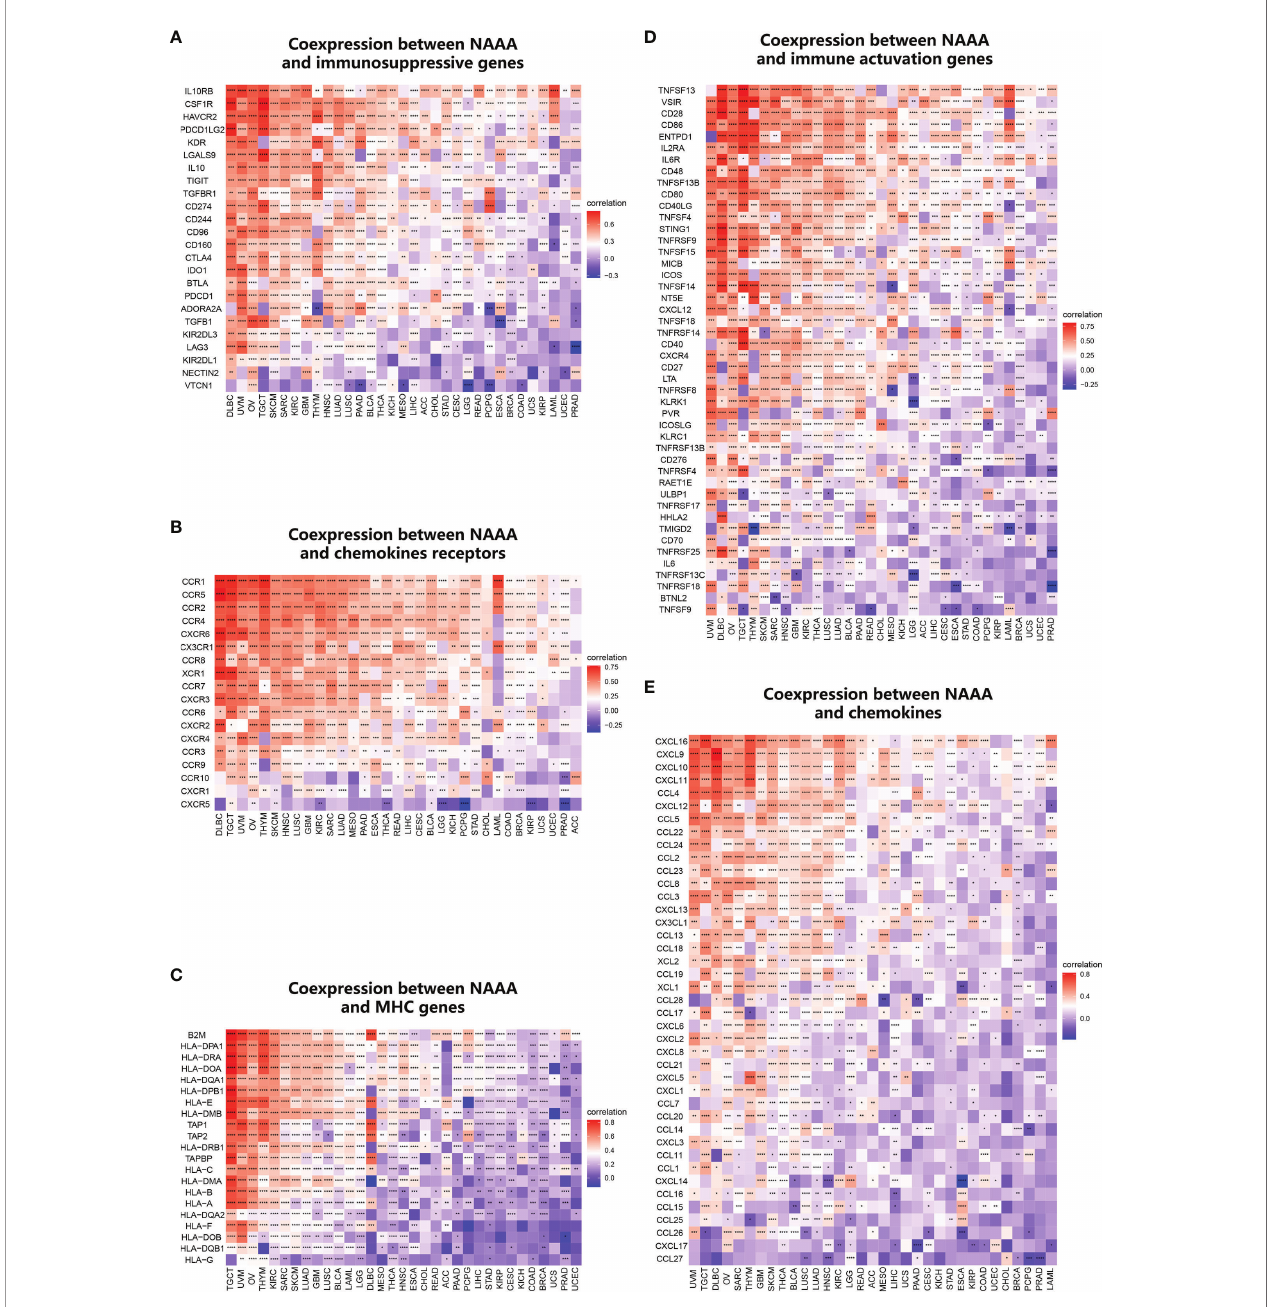
FIGURE 12 | Co-expression of NAAA with immune-associated genes. Co-expression between NAAA and (A) MHC genes, (B) immune activated genes, (C) immunosuppressive genes, (D) chemokines, (E) chemokine receptors. *p < 0.05, **p < 0.01, ***p < 0.001, and ****p < 0.0001. Genes encoding MHC, immune activation, immune suppression, chemokine, and chemokine receptor proteins were